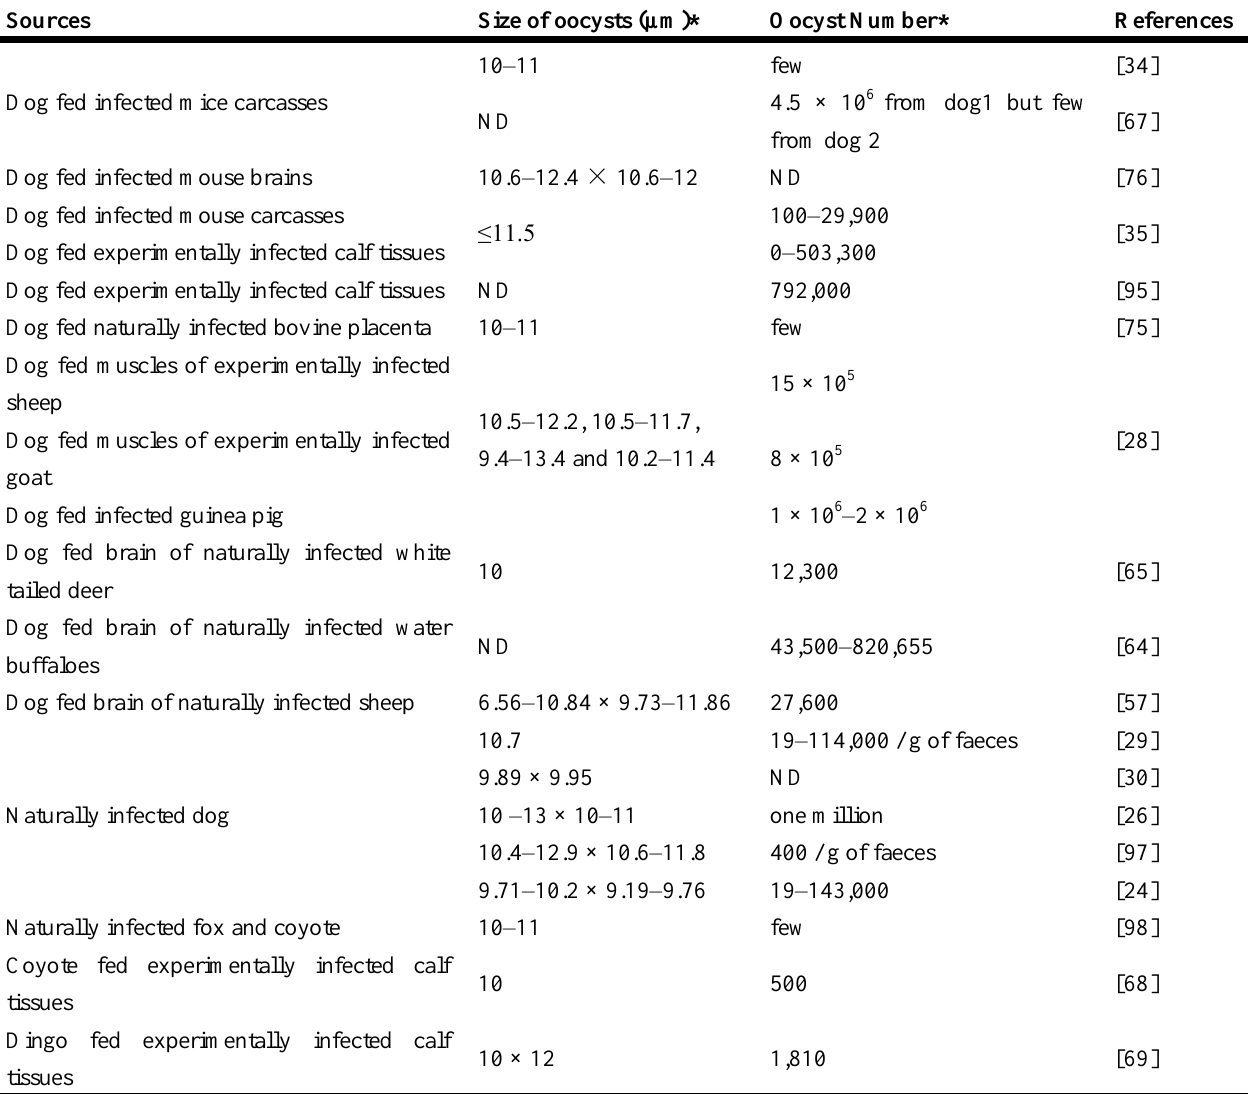
Table 5. Sizes and numbers of oocysts shed by